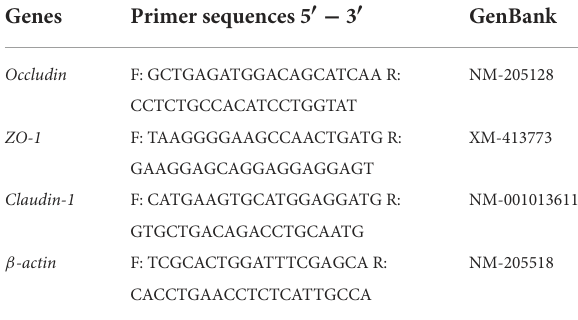
TABLE 2 Primer sequences of chicken Occludin , ZO-1 , Claudin-1 , and β -actin genes used for RT-qPCR.